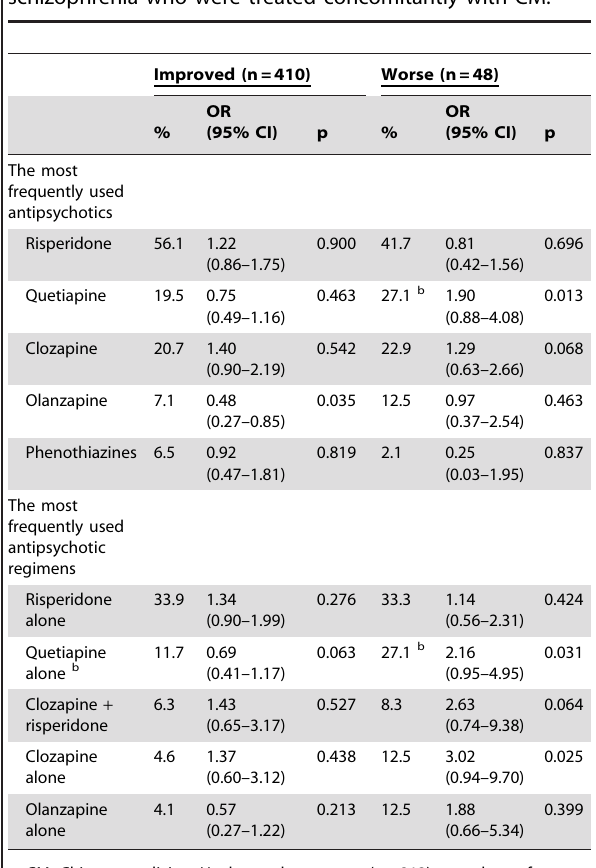
Table 4. Multivariate associations between clinical outcomes and antipsychotic medication modes in patients with schizophrenia who were treated concomitantly with CM.